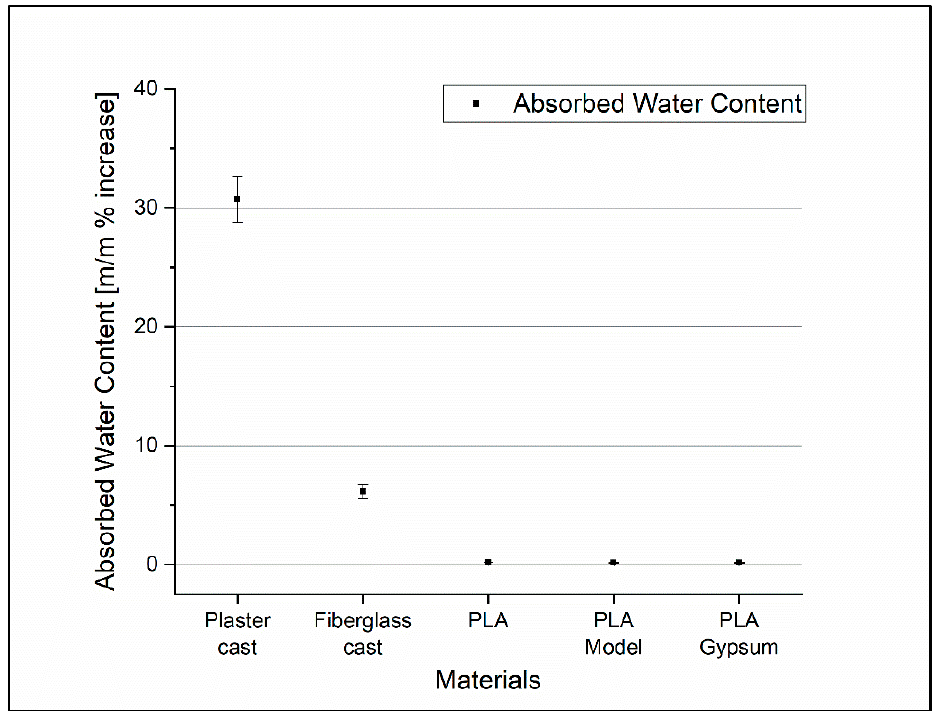
Figure 10. The change in mass of examined materials in percentage and their standard deviations. Percentage change and standard deviation of the mass of the test substances.